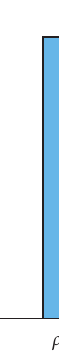
Figure 4: Fairness index under the state with no manipulation ( ρ � 0) and the steady state with manipulation ( ρ �